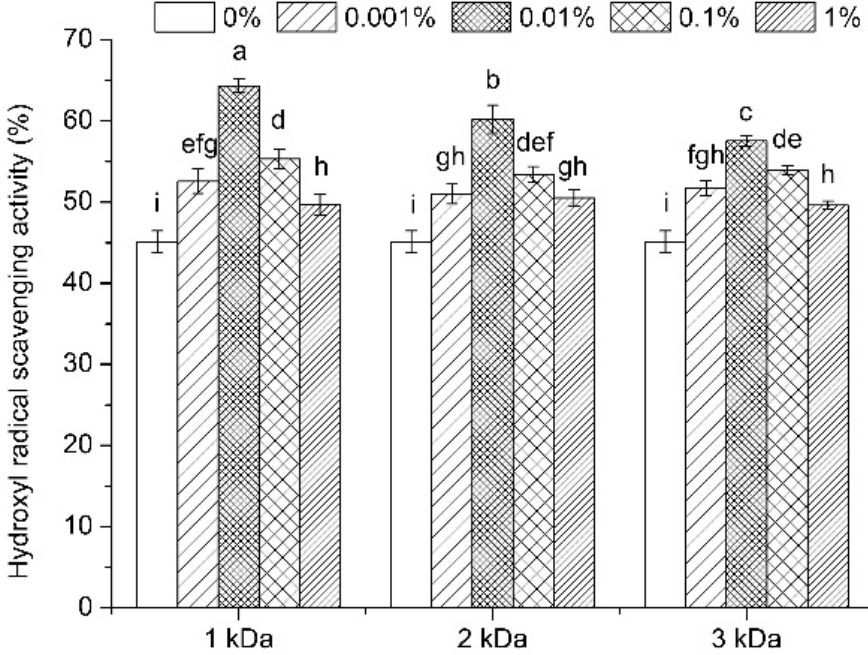
Figure 5. Hydroxyl radical scavenging activity of soybean sprouts under different chitooligosac- charide treatments. The treatments were conducted with chitooligosaccharides of three molecular weights (1, 2, and 3 kDa) at four different concentrations (0.001 to 1%). The control treatment (0%) included the same solutions without chitooligosaccharides. Vertical bars represent the standard error of three replicates. Different letters indicate statistically significant difference ( p < 0.05).